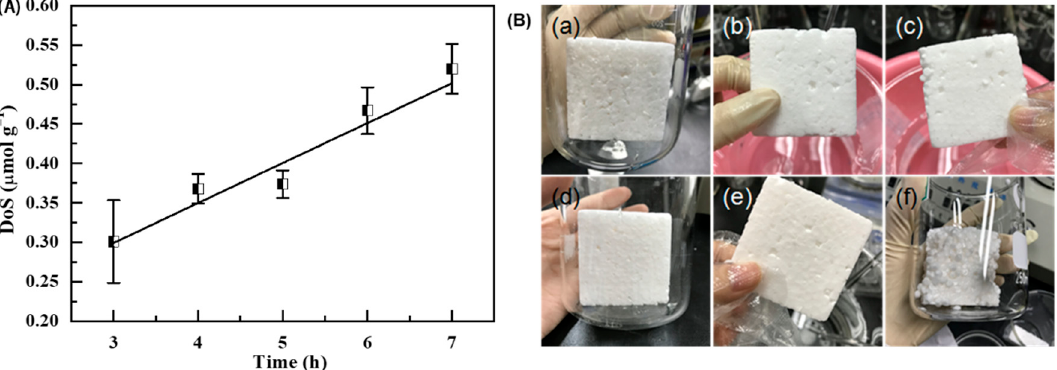
Figure 1. ( A ) DoS as a function of sulfonation time, and ( B ) digital photos of SPS foams with sulfonation times of ( a ) 3, ( b ) 4, ( c ) 5, ( d ) 6, ( e ) 7 and ( f ) 8 h.